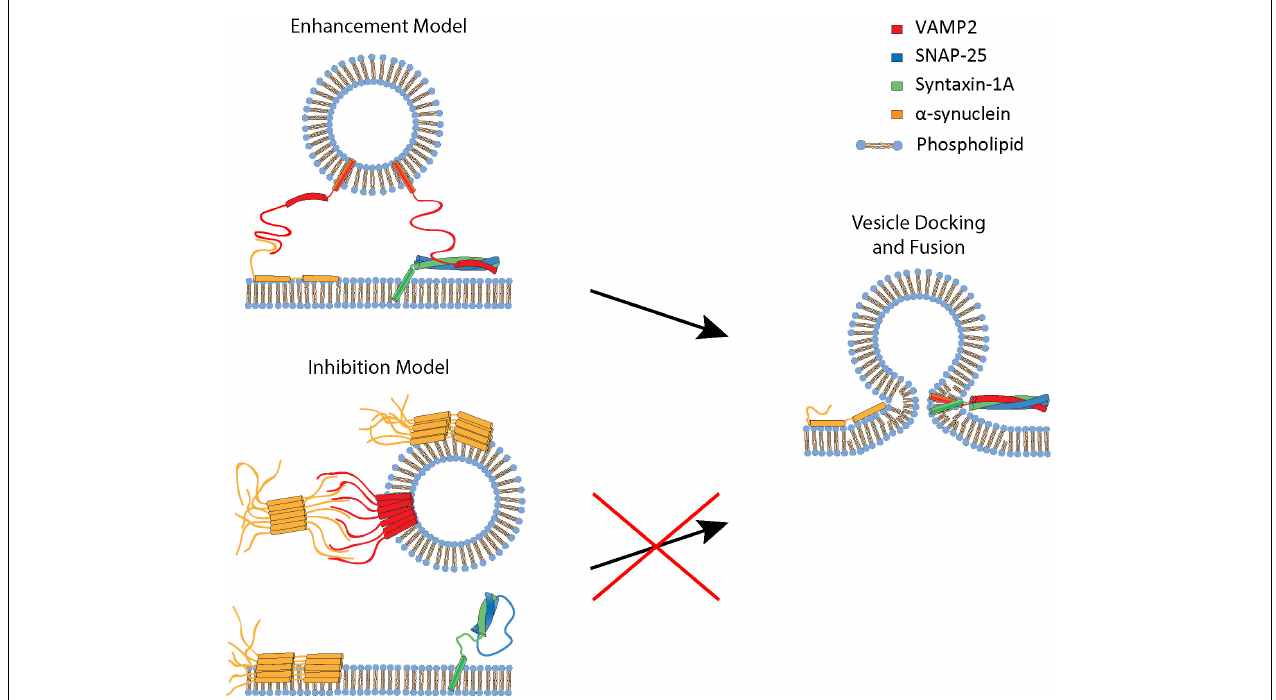
FIGURE 5 | A proposed mechanistic model for enhancement and inhibition of SNARE-dependent vesicle fusion by α S. The enhancement model involves monomeric α S acting as a cross-bridge to facilitate vesicle docking to the phospholipid bilayer. α S has a N-terminal membrane binding region that binds to the phospholipid bilayer and the C-terminal region that interacts with VAMP2 (Lou et al., 2010). The inhibition model involves oligomeric, multivalent α S interacting and clustering VAMP2, thus preventing it from engaging in SNARE complex formation and vesicle fusion.